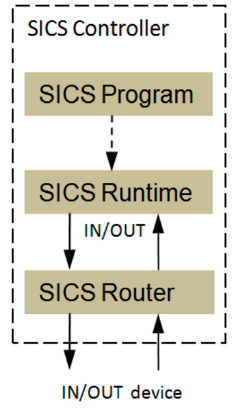
Figure 4. General structure of a smart industrial control service (SICS) controller.